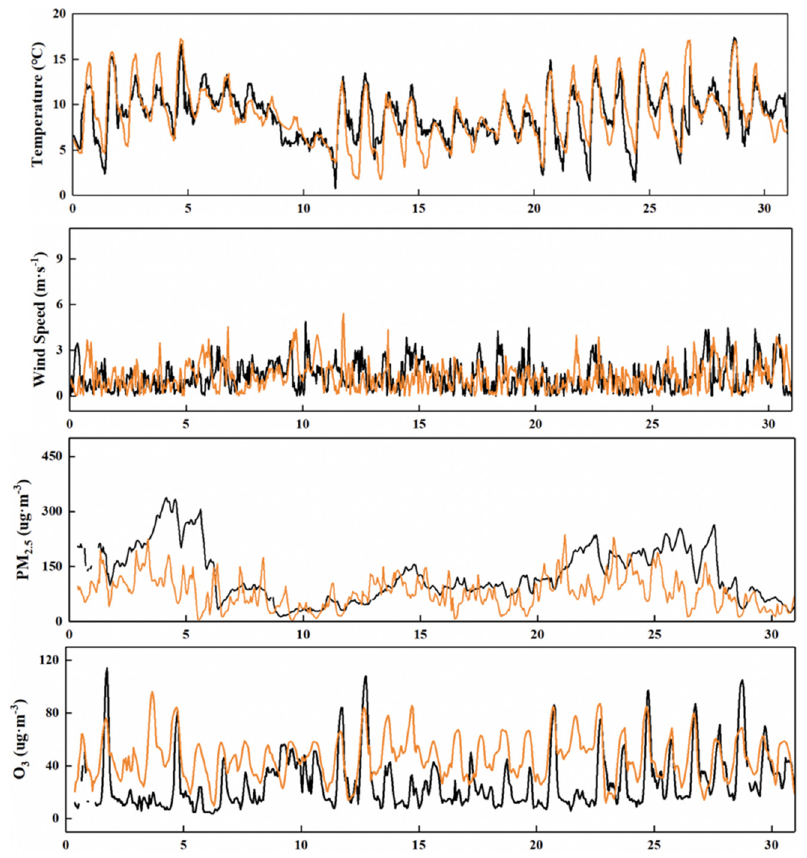
Figure 2. Time series of temperature at 2 m (T2), wind speed at 10 m (U10), PM 2.5 and O 3 concentration in Chengdu in January 2017. Black is the observed value and orange is the simulated